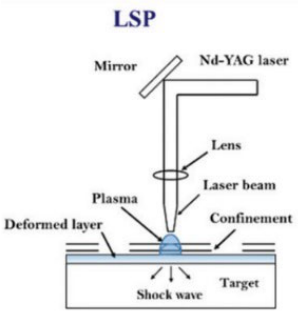
Figure 5. Schematic illustration of the LSP process reprinted from ref. [23]. Copyright 2022 Market- place.